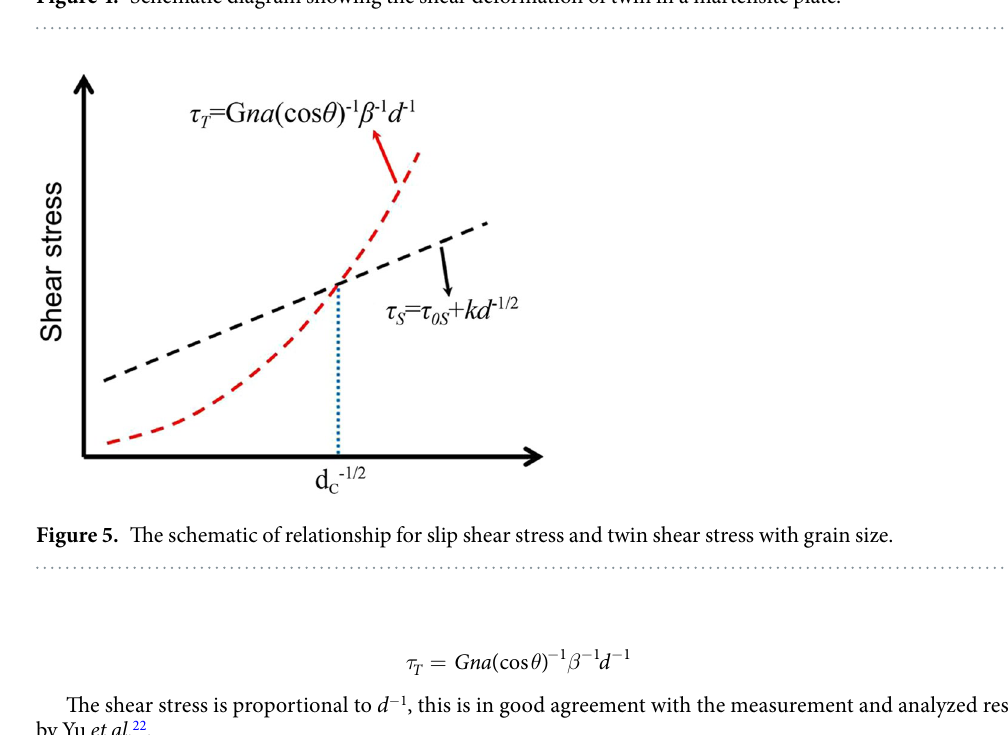
Figure 4. Schematic diagram showing the shear deformation of twin in a martensite plate.